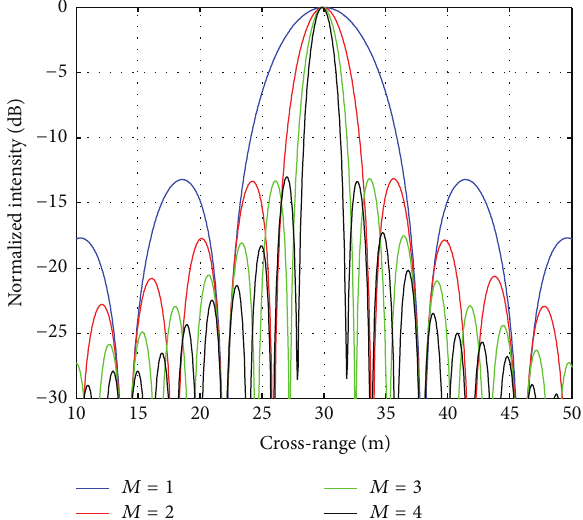
Figure 8: ISAR profiles for nonnegligible rotation